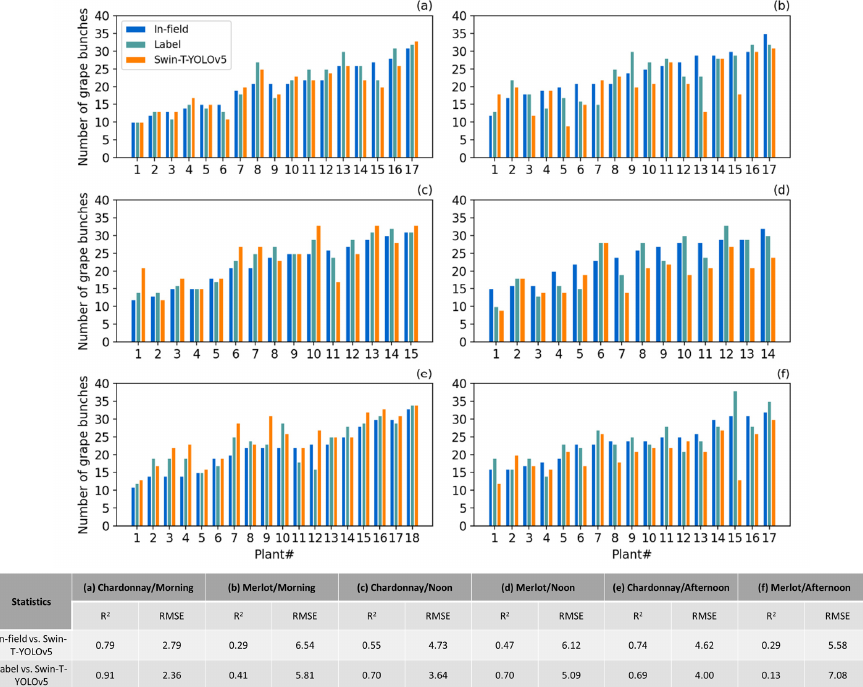
Figure 8. The number of grape bunches comparison between in-field manual counting (gTruth), manual label, and detection using Swin-transformer-YOLOv5 (Swin-T-YOLOv5) during ( a , b ) morn- ing; ( c , d ) noon; ( e , f ) afternoon with Chardonnay (left) and Merlot (right). RMSE refers to root mean square error. Plant# refers to the number of